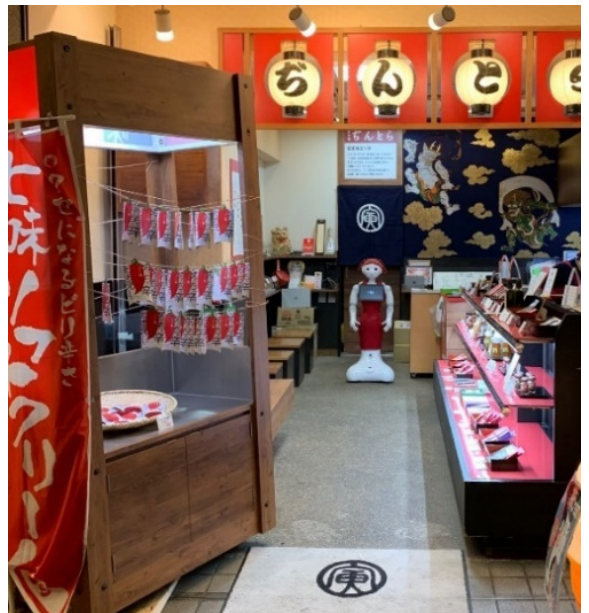
Figure 2. Interior of the shop as viewed from the entrance.